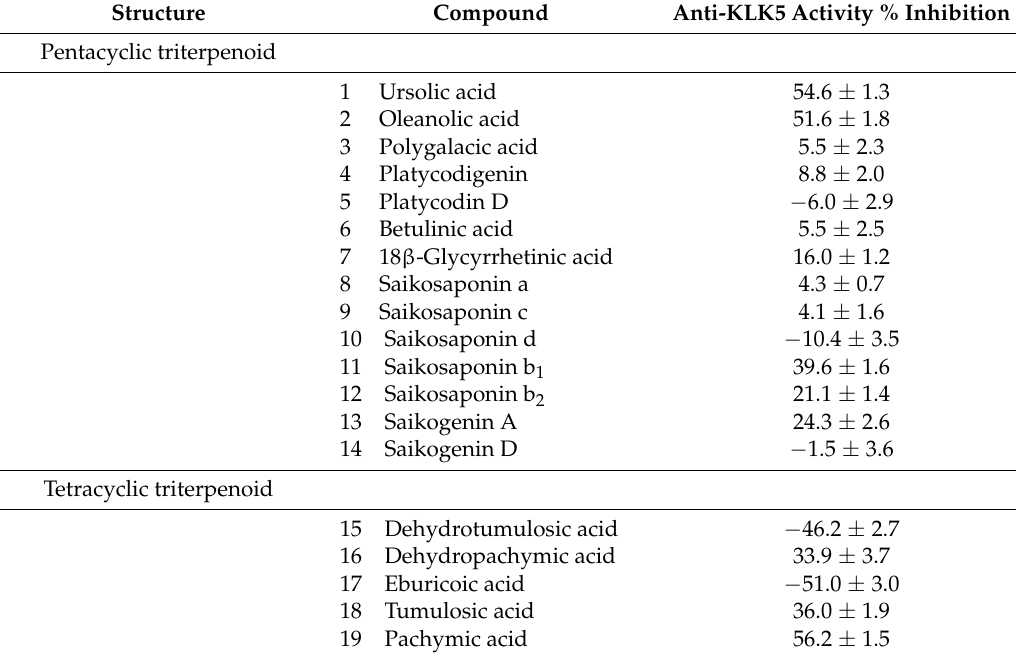
Table 1. Random assay to identify triterpenoids with anti-KLK5